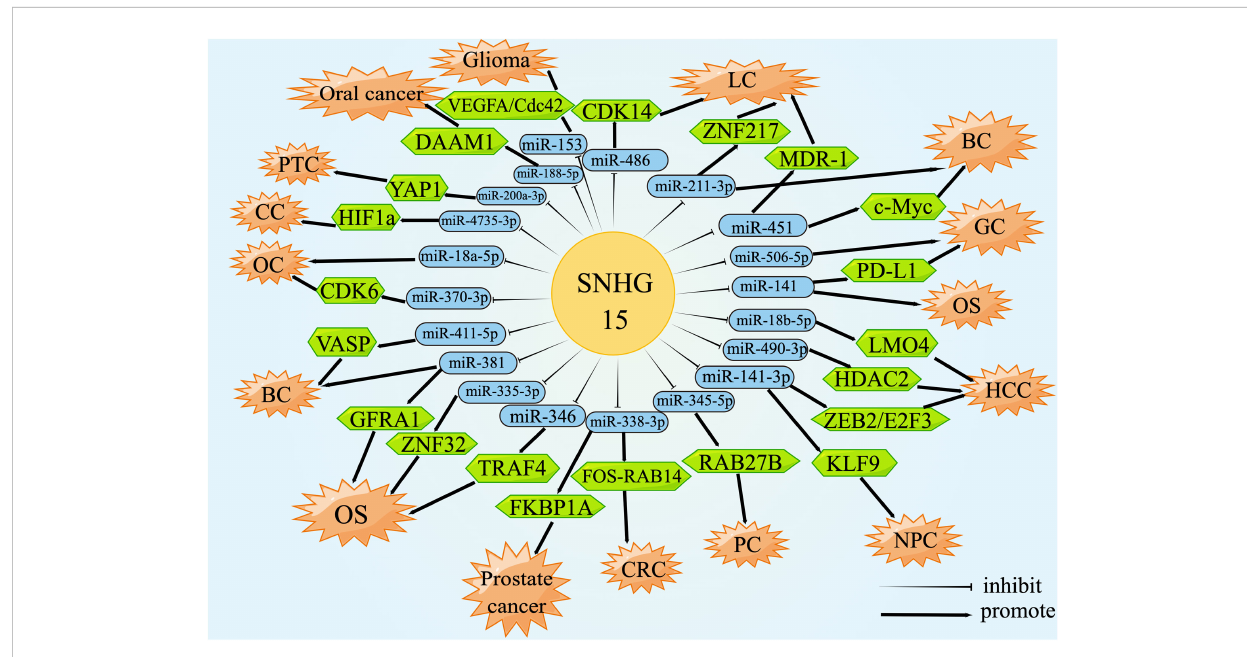
FIGURE 2 lncRNA SNHG15 function through ceRNA mechanism. SNHG15 could sponge miRNAs or serve as ceRNA by occupying the shared binding sequences of miRNAs, thus sequestering miRNAs and changing the expression of downstream target